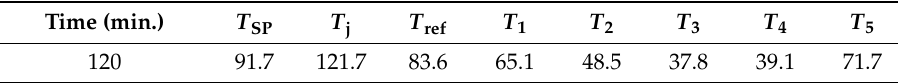
Figure 9. Chart of specified points of T sp , T j , T ref , T 1 , T 2 , T 3 , T 4 , and T 5 temperature distributions for the ALFHS mounted to the CLRDL after INST. Table 2. Temperature ( ◦ C) distribution of specified points for ALFHS mounted to the CLRDL after INST in the steady ‐ state.